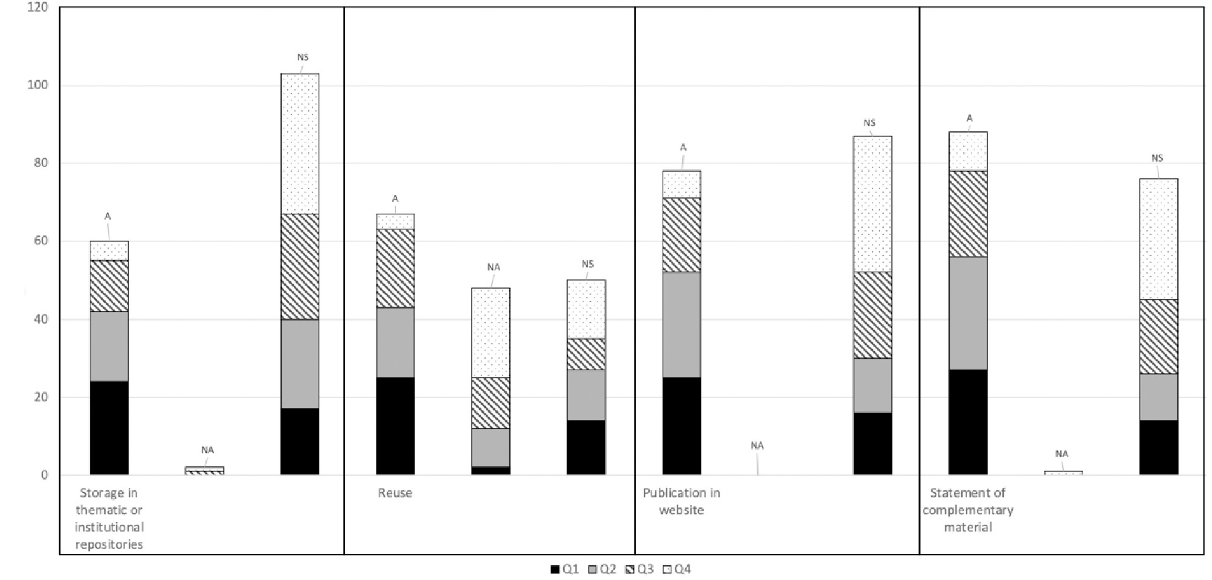
Fig 1. Key findings regarding open access and open data policies of the journals listed in the “Medicine, General & Internal” category.